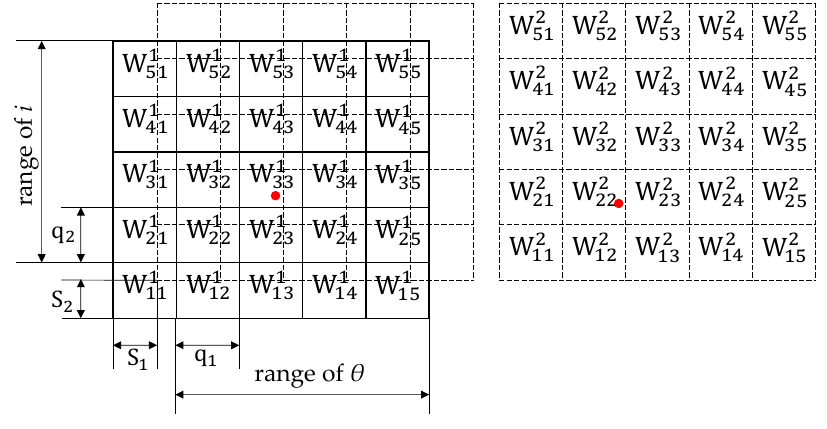
Figure 5. 2-layer memory structure of CMAC.